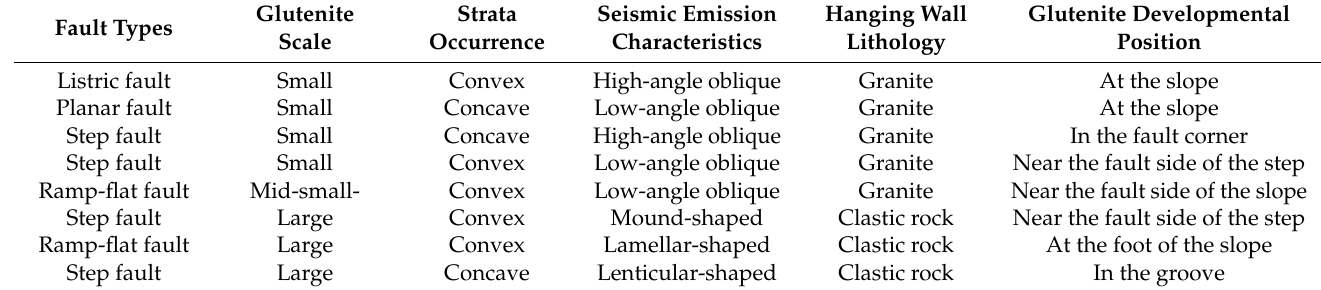
Table 3. Types and characteristics of glutenite bodies in the Guojuzi area.